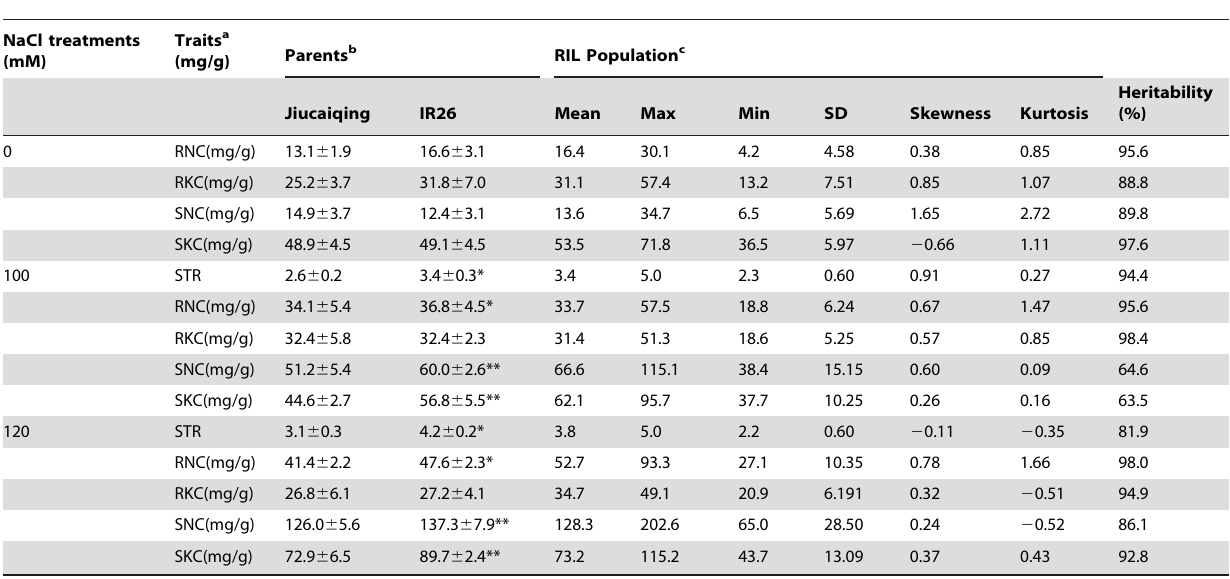
Table 1. Phenotypic performance of relevant traits in two parents and RIL population (Jiucaiqing/IR26) under different NaCl conditions.